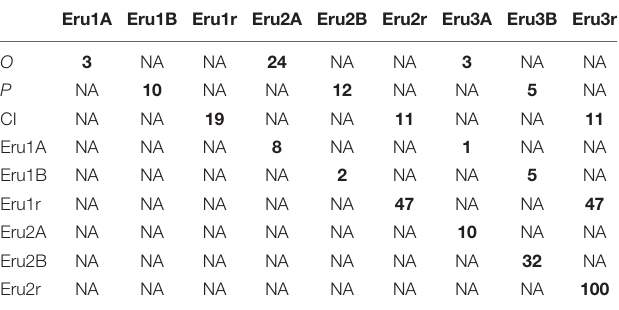
The given numbers (bold) indicate the allover sequence identity between query protein (first column) and subject protein (upper row). The sequences of the Eru1, Eru2, Eru3, and the lambdoid proteins are derived from the TL-2011c phage, the EHEC O157:H7 strain TW14359, the STEC O157:H7 strain F8952, and the 933W phage, respectively. NA Not